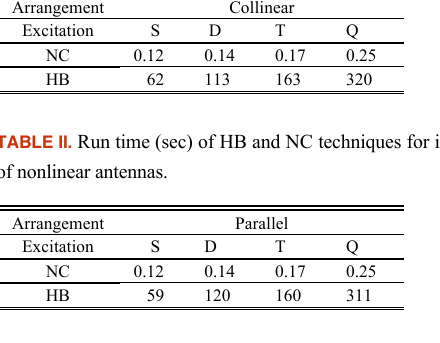
TABLE III. Run time (sec) of HB and NC techniques for infinite planar array of nonlinear